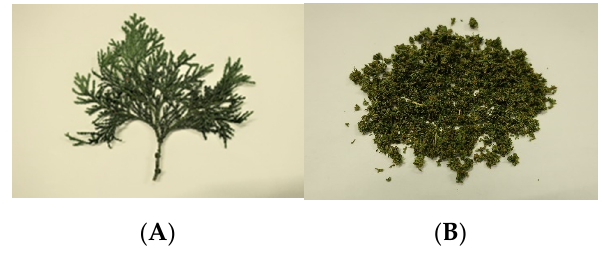
Figure 2. ( A ) Hinoki leaf; ( B ) Hinoki leaf